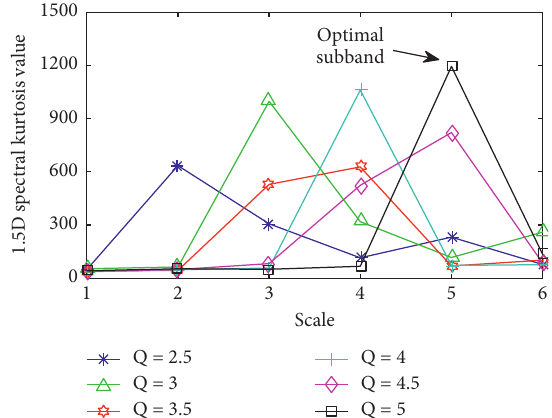
Figure 5: Optimal subband selection process of the 1.5D spectral kurtosis-guided TQWT